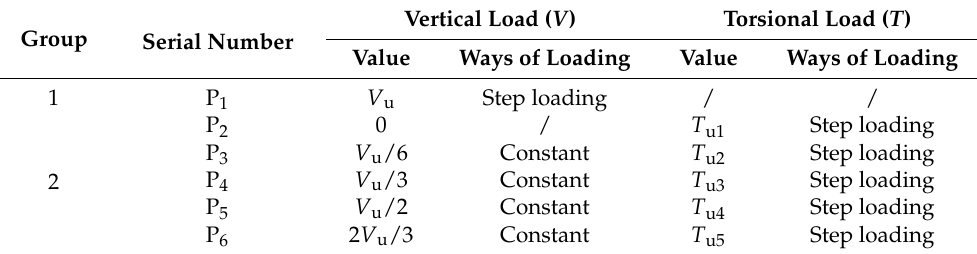
Table 2. Test loading